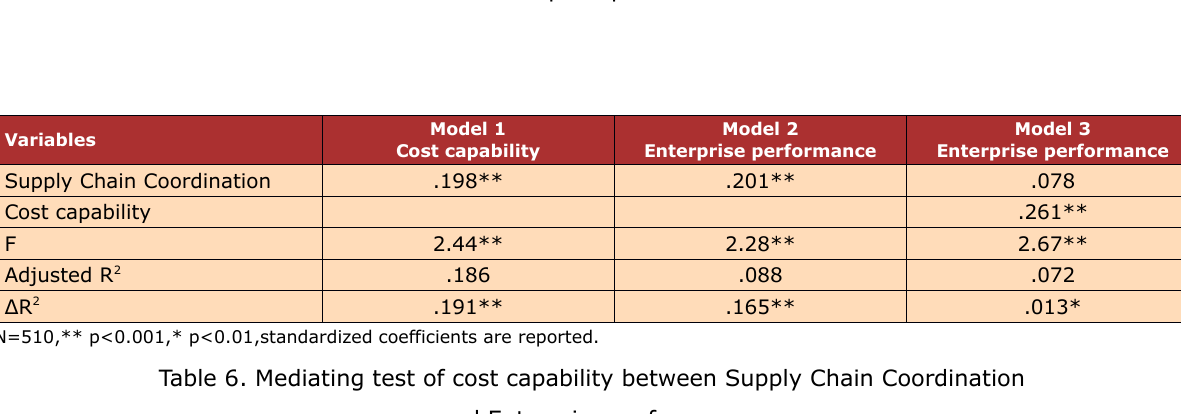
Table 5. Mediating test of Quality Capability between Supply Chain Coordination and Enterprise performance